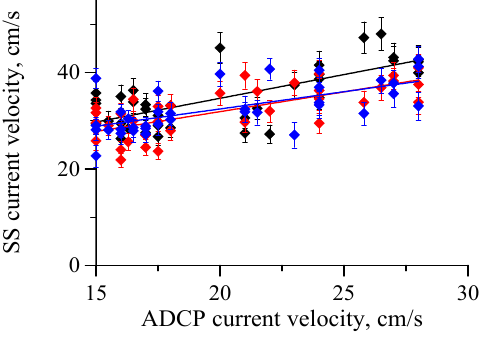
Figure 6. Subsurface current velocity vs. ADCP current velocity at a depth of 1 m. Case study 4.2. Black symbols—S-band, red—C-band, blue—X-band.